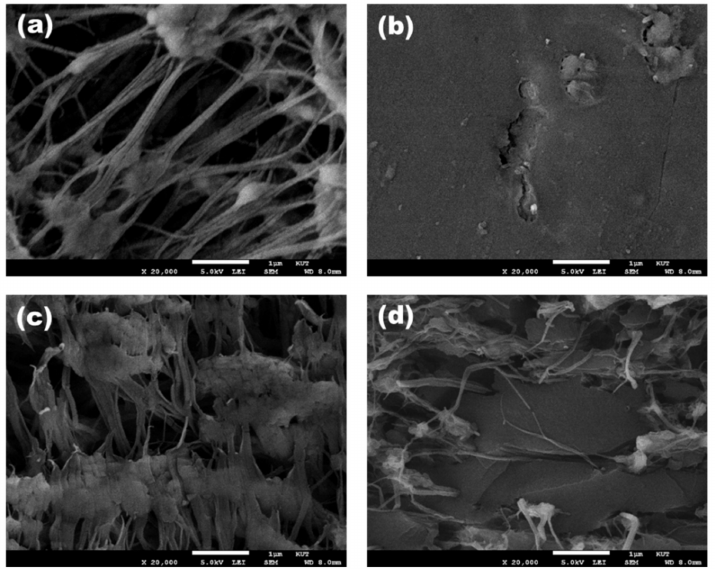
Figure 2. FE-SEM images of porous substrate and pore-filled membrane: surface—(( a ) PTFE porous substrate; ( b ) pore-filled membrane) and cross-section—(( c ) PTFE porous substrate; ( d ) pore-filled